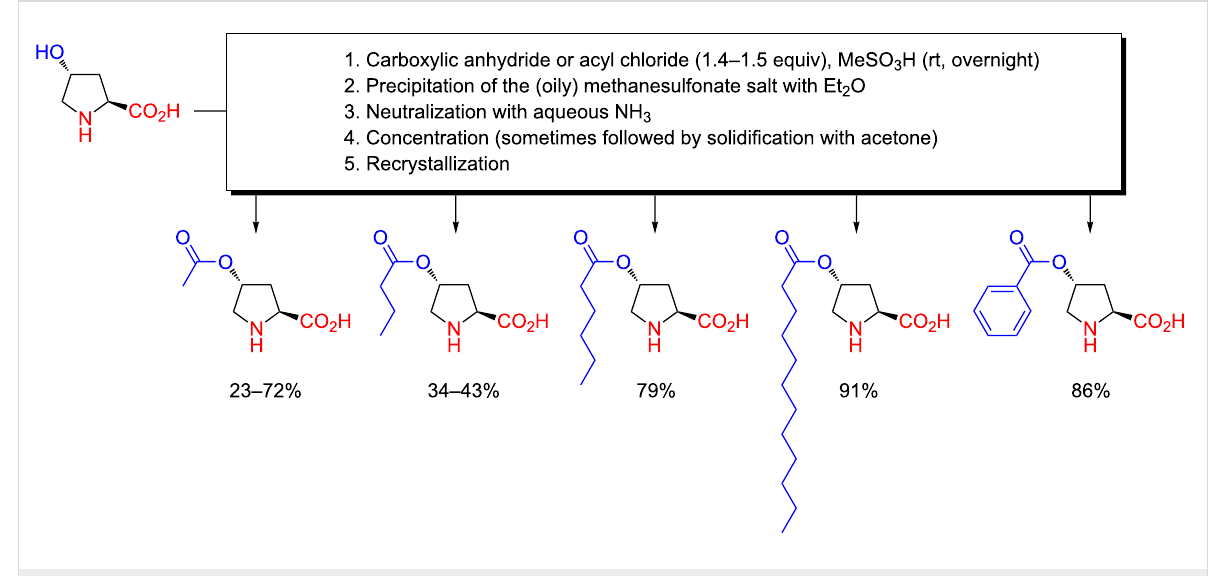
Scheme 6: Chemoselective O -acylation of hydroxyproline with acyl chlorides or carboxylic anhydrides in methanesulfonic acid as reported by Kawasaki and Komai in 1983